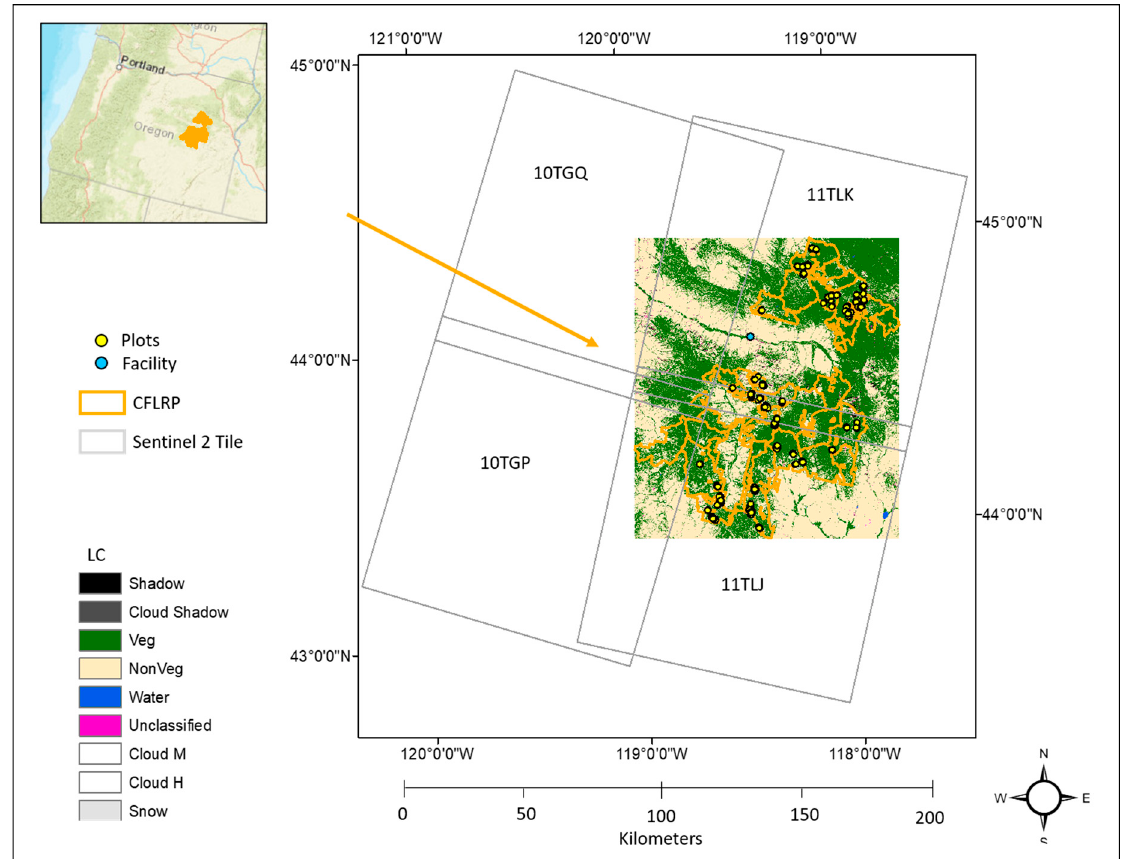
Figure 2. A map of the study site, Malheur Lumber Company in the Blue Mountains of Oregon (Facility), Sentinel 2 tiles, Sentinel 2a land cover (LC) surface [45] denoting the analysis extent of the study, monitoring plot locations, and the boundary of the Collaborative Forest Landscape Restoration Program (CFLRP).